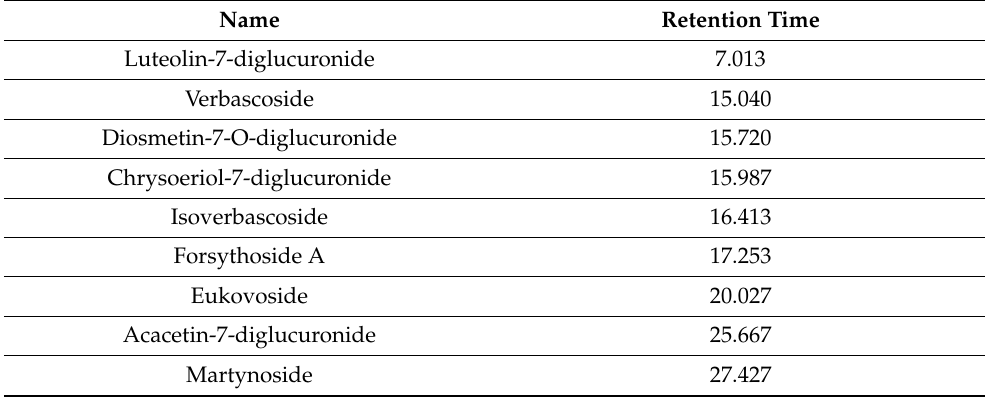
Figure 2. Chromatogram of the lemon verbena extract used in the study, analyzed at 330 nm. Table 1. HPLC analysis